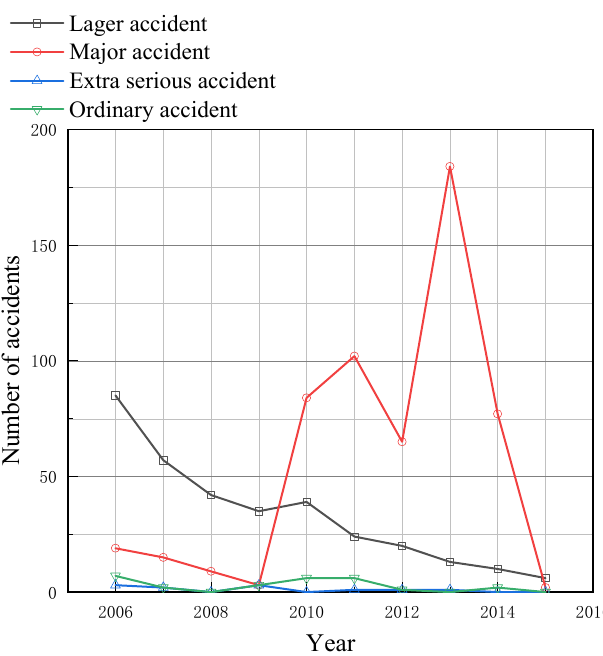
Figure 1. Chinese coal and methane outbursts from 2006 to 2015.